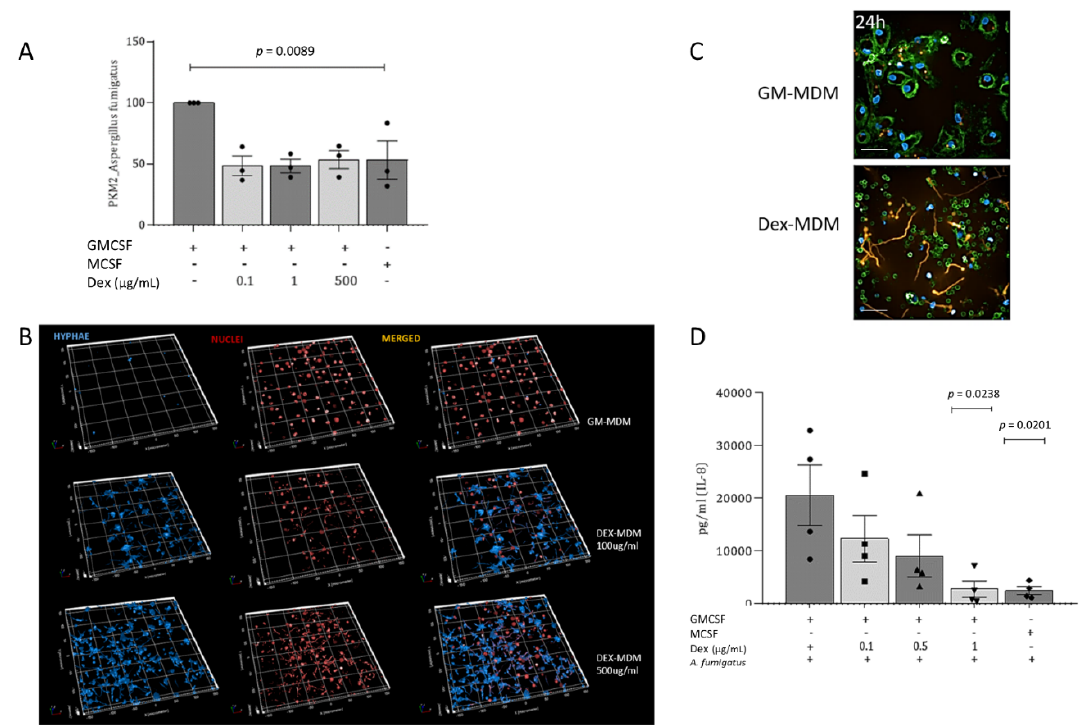
Figure 5. Fungal infection does not restore PKM2 levels in Dex-MDMs, and Dexamethasone treatment accelerates fungal growth by suppressing pro-inflammatory immune responses. ( A ) Upon treatment of the various MDM subsets (GM-, Dex, M-MDM) using A. fumigatus , PKM2 levels remained significantly lower in M- and Dex-MDMs, independently of the Dex-concentration used. M2-MDMs served as controls. Experiments were repeated independently three times, and statistical significance was evaluated using one-way ANOVA. ( B ) A. fumigatus was successfully suppressed in MDMs cultured in the presence of GM-CSF (M1), while Dex-MDMs were more prone to fungal infection and outgrowth. Nuclei were stained using Draq5 (red) and fungi using calcofluor (blue). The staining was independently performed 3 times. ( C ) Hyphal growth was only detectable in Dex-MDMs after overnight incubation, while GM-MDMs phagocytosed the fungal conidia (orange) but did not allow outgrowth. Nuclei were stained using Höchst (blue), cell surface using WGA (green). The experiment was repeated three times. Scale bar, 50 µm. ( D ) Impairment in IL-8 secretion was analyzed after stimulation with A. fumigatus in both Dex- and M-MDMs compared to IL-8 levels in A. fumigatus -exposed GM-MDMs. The most significant decrease in IL-8 production occurred in a Dex-concentration-dependent manner, and at the highest Dex-concentration tested (1 µg/mL), Dex-MDMs secreted as little IL-8 as M-MDMs upon fungal infection. The experiment was repeated four times due to donor-specific differences in cytokine secretion. All four experiments are depicted; statistical significance was calculated using ANOVA.